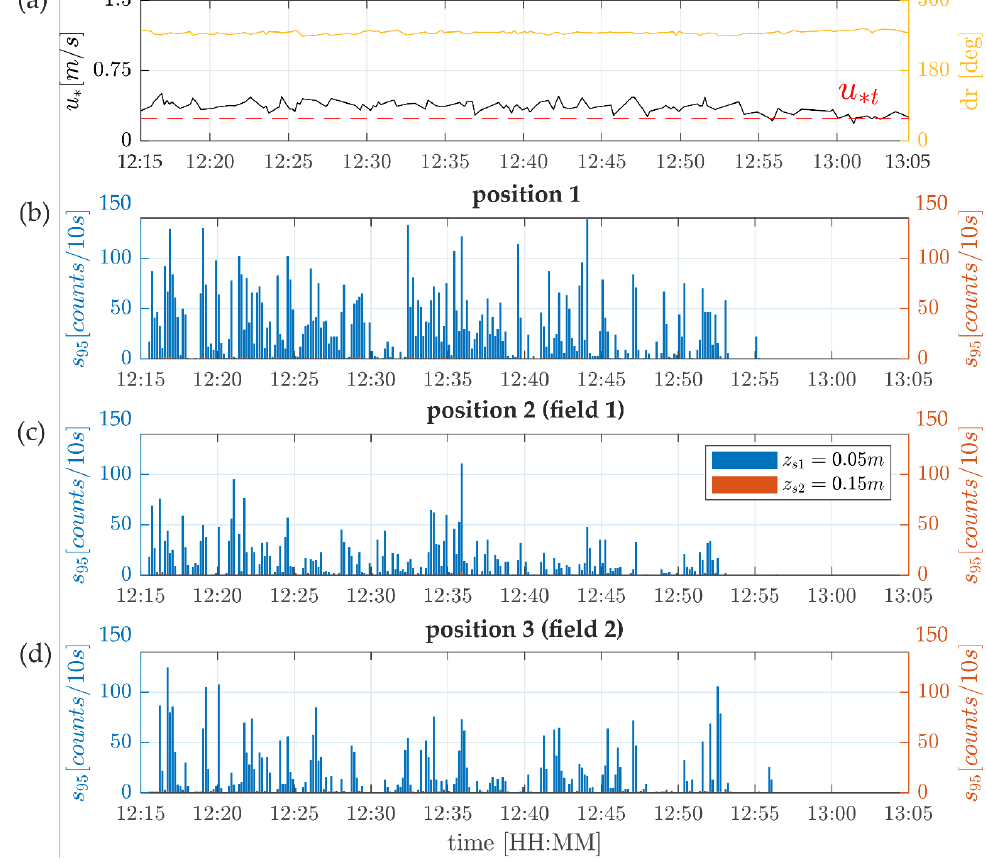
Figure 13. Time series of the ( a ) shear velocity, critical shear velocity, mean wind direction , and ( b , c , d ) 95% quantiles of saltation impacts over 10-s time intervals for the measurement location of the dune